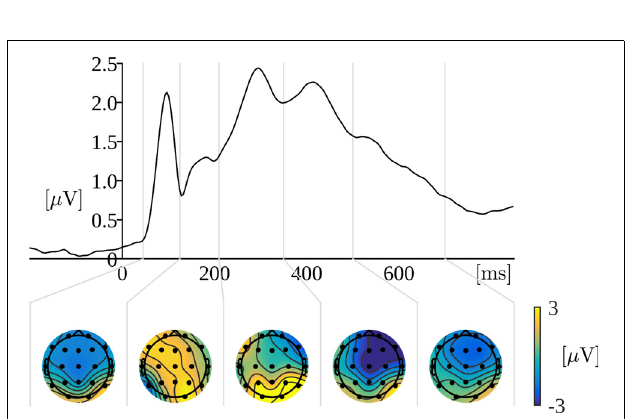
FIGURE 5 | Upper curve: Global field power for the decision-making part of the trials. Time 0 is the moment of key-press. Lower plots: Topographical distribution of grand mean amplitudes across participants and conditions within the indicated time